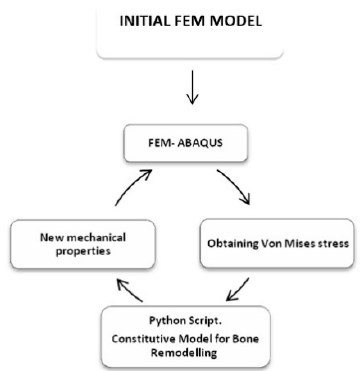
Figure 2. Flow diagram with information of the finite element analysis (FEA) model and the bone reconstitution model for each year of the study period considered (10 years).